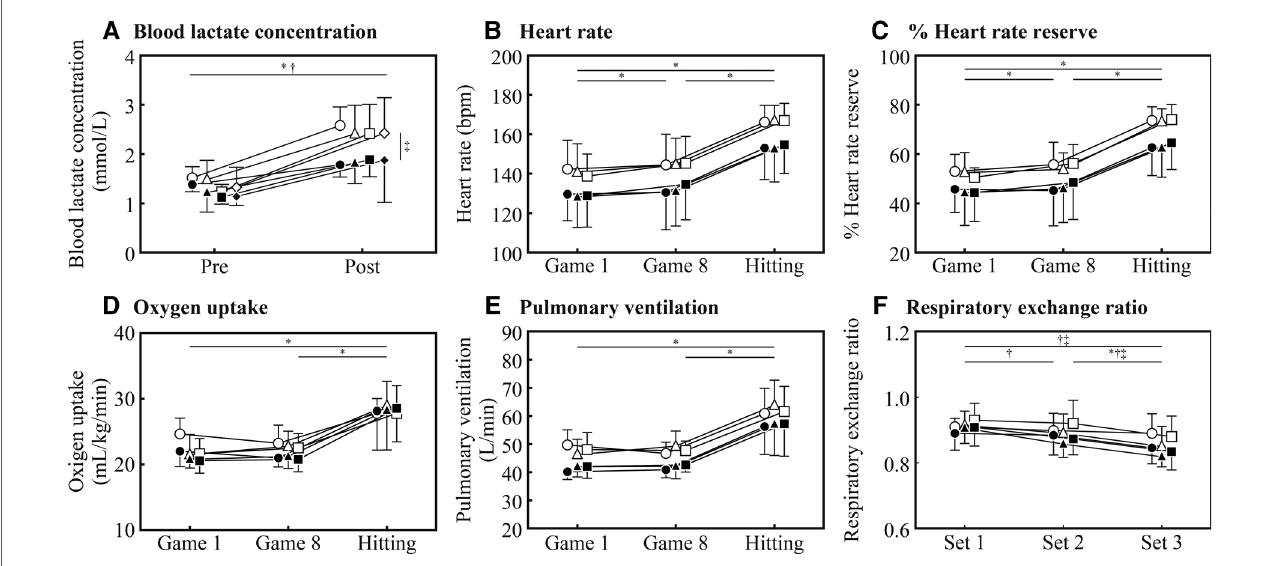
FIGURE 2 Physiological measurements at each time point. The HIGH group is indicated by a white symbol and the LOW group by a black symbol. ( A ) Blood lactate concentration pre and post hitting test before the simulated match-play tennis protocol and each set. Circles indicate pre-test, triangles, squares, and diamonds indicate 1st to 3rd sets, respectively. Signi fi cant differences between pre and post in HIGH and LOW are marked with “ * ” or “†” , respectively. Signi fi cant differences between HIGH and LOW in post are marked with “‡” . ( B – E ) Heart rate, % Heart rate reserve, oxygen uptake and pulmonary ventilation at each time point (game 1, game 8 and Hitting test). Circles, squares, and diamonds indicate 1st to 3rd sets, respectively. Signi fi cant differences between time points are marked with “ * ” . ( F ) Respiratory exchange ratio at each time point (set 1, set 2 and set 3). The HIGH group is indicated by a white symbol and the LOW group by a black symbol. Circles indicate pre-test, triangles, squares, and diamonds indicate game 1, game 8 and the hitting test, respectively. Signi fi cant differences in RER between sets at each time point, game 1, game 8 and the hitting test are marked with “ * ” , “†” and “‡” , respectively.